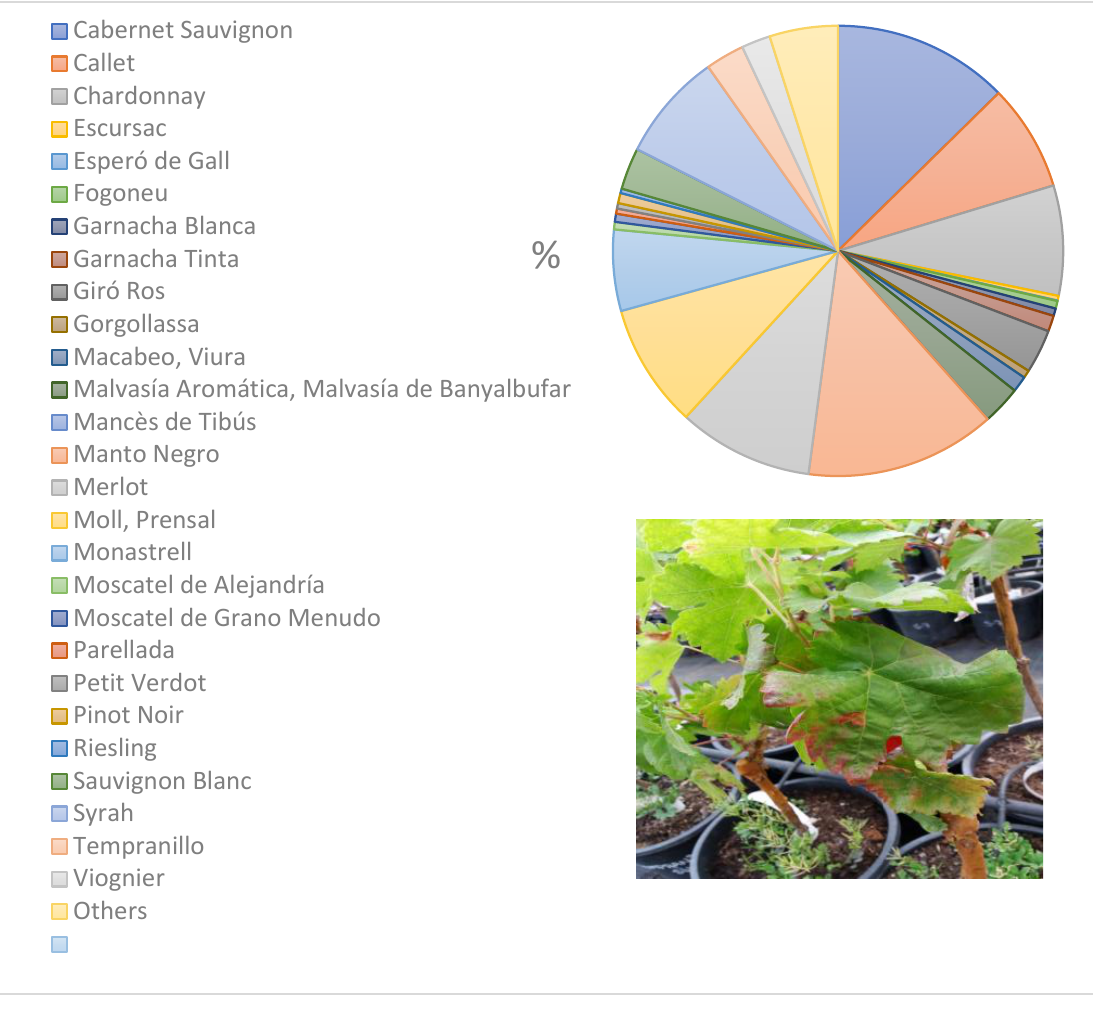
Figure 4. Diversity and surface-area proportions of grapevine varieties planted in Mallorca. All these varieties have been shown to be susceptible to Xylella fastidiosa in the field and in inoculation experiments. Symptoms of a grapevine (var. Tempranillo) seven weeks after inoculation (bottom).